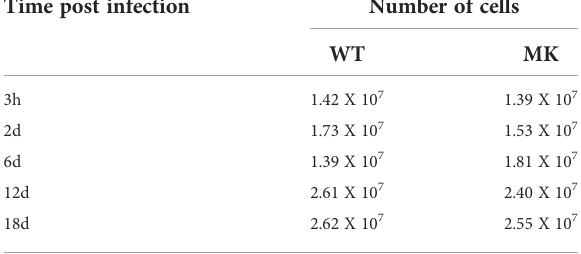
TABLE 4 Number of 3T3-L1 cells at different time-points. HAdV-36- infected vs MK-infected at 12 dpc in MM. Time post infection